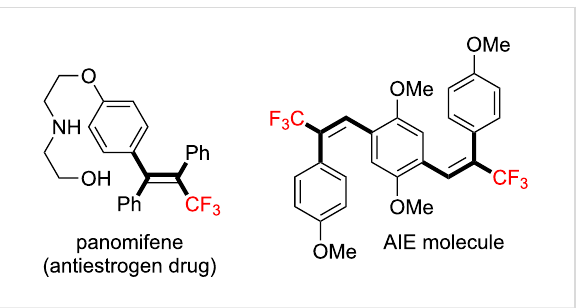
Scheme 1: Representative examples of multisubstituted CF 3